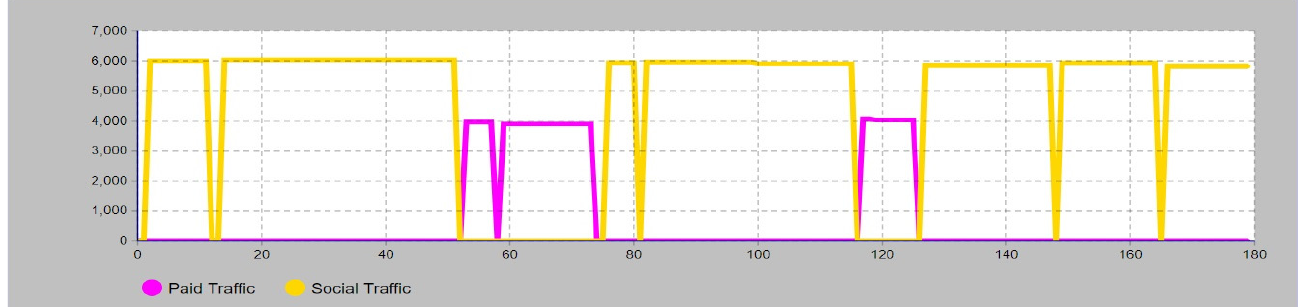
Figure 7. Paid and Social traffic changes in 180 simulation days .